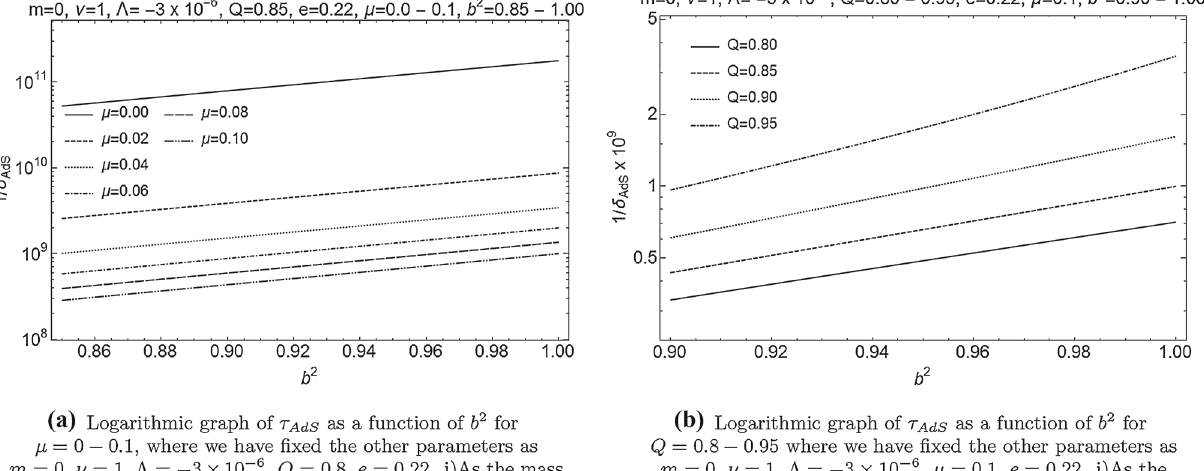
monopole grows we observe that the time scale decreases. The values of the parameters in the graph are chosen such that the superradiance conditionissatisfied.Notethat,blackholechargevaluesinthesegraphs are lower than the corresponding values of Q c given in Eq.